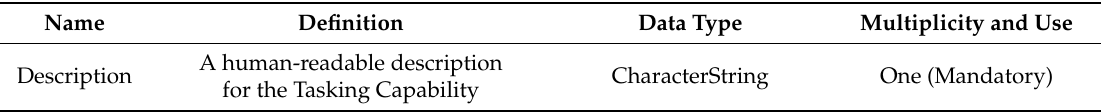
Table 1. Properties of the TaskingCapability .